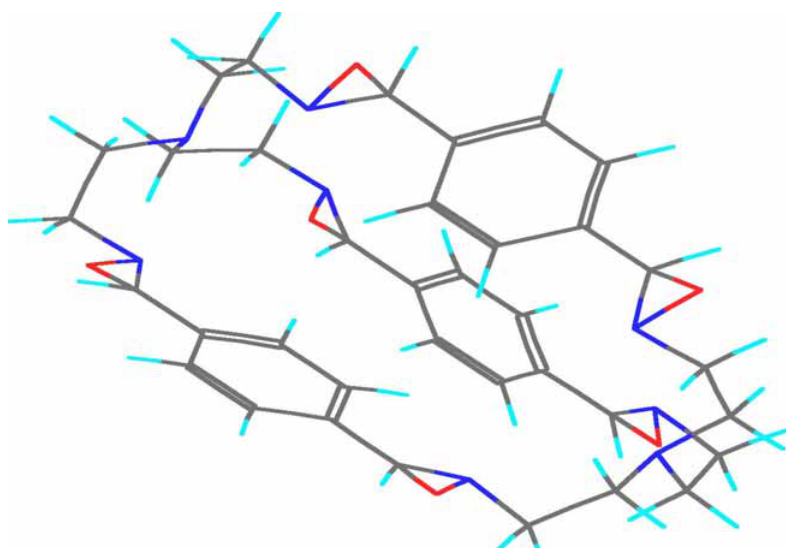
Figure 6. Structure of hexaoxaziridine 5 (Macromodel) showing the two enantiomeric sets of (R,R) and (S,S)